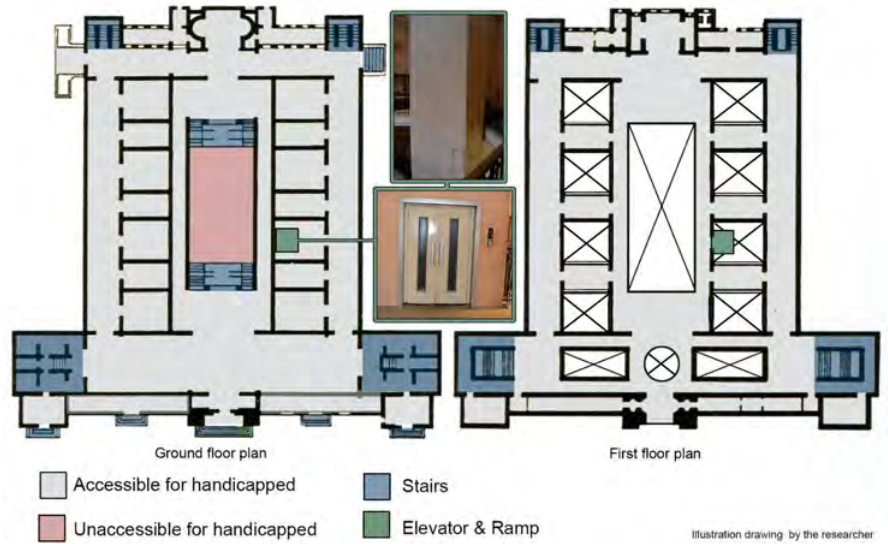
Figure 9. Analyzing plan for accessibility for the Egyptian